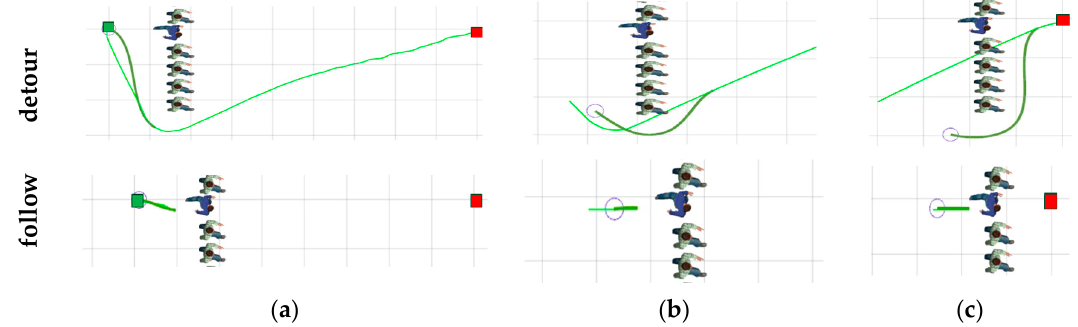
Figure 11. Performance comparison between planners with and without the follow mode. The green curves and lime curves represent the local trajectories and global path, respectively. ( a , b,c ) The trajectories generated in three positions with and without the follow mode.